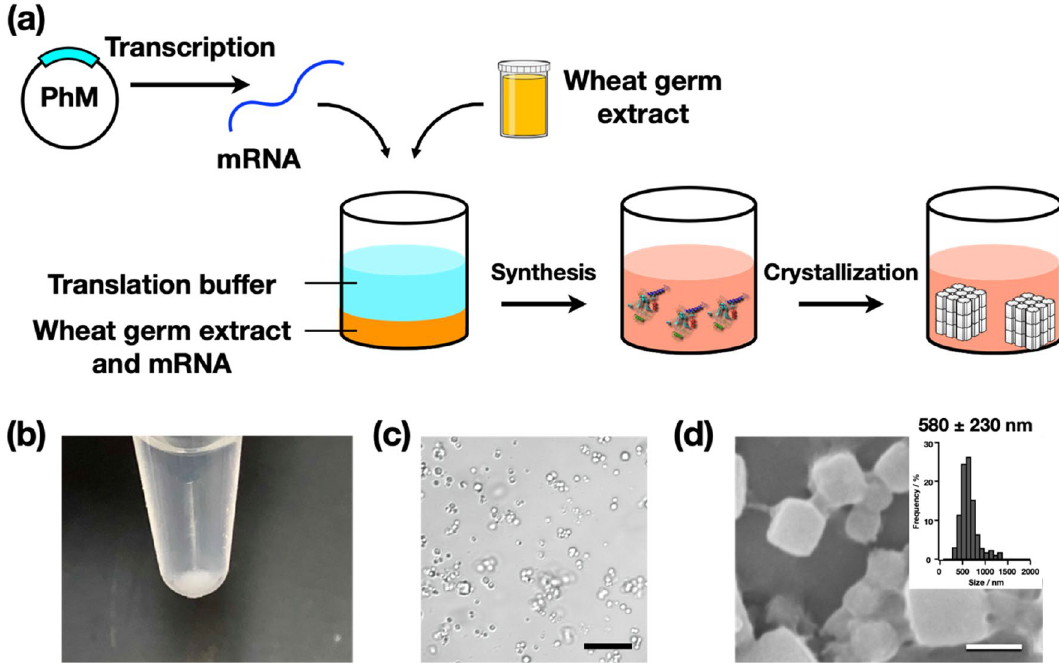
Figure 1. ( a ) Schematic illustration of cell-free protein crystallization (CFPC) of polyhedrin monomer (PhM) using the Wheat Germ Protein Synthesis kit. ( b ) Photograph of the tube after CFPC. ( c ) Differential interference contrast (DIC) image of PhC_CF . Scale bar 10 μm. ( d ) A scanning electron micrograph of PhC_CF . Size distribution of PhC_CF determined by the SEM image. Scale bar 1